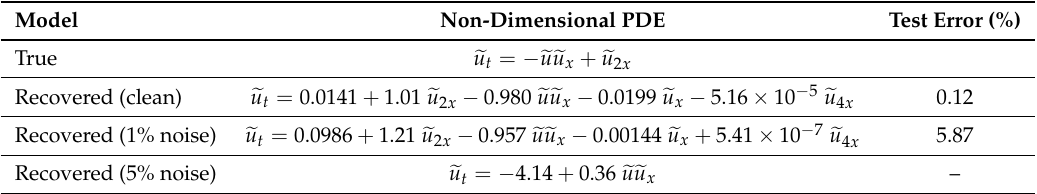
Table 6. Identifying Burgers equation using FFX.